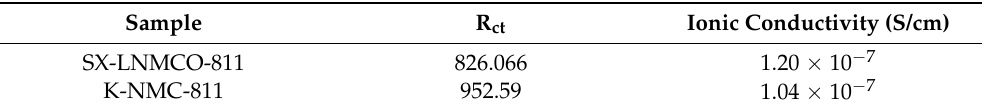
Table 9. The data of R ct and ionic conductivity of the cells with SX-LNMCO-811 and K-NMC-811 cathode precursors.